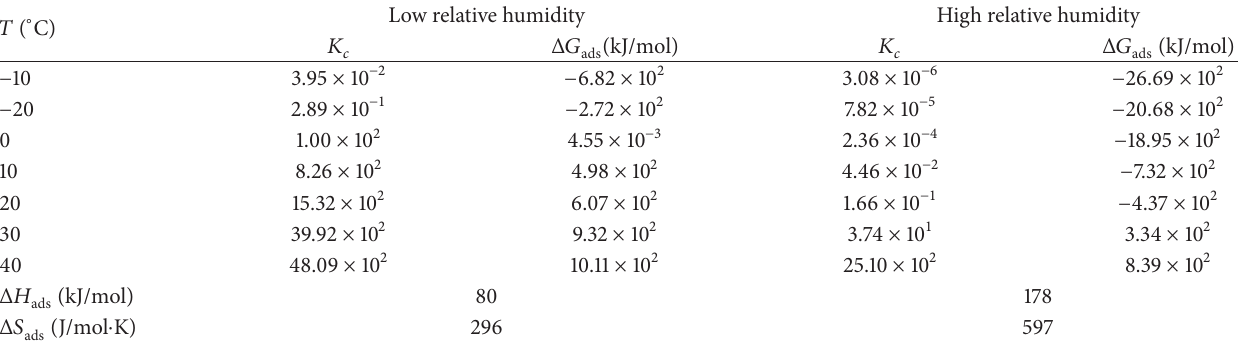
Table 4: Thermodynamic parameters for CO 2 adsorption onto treated fly ash.